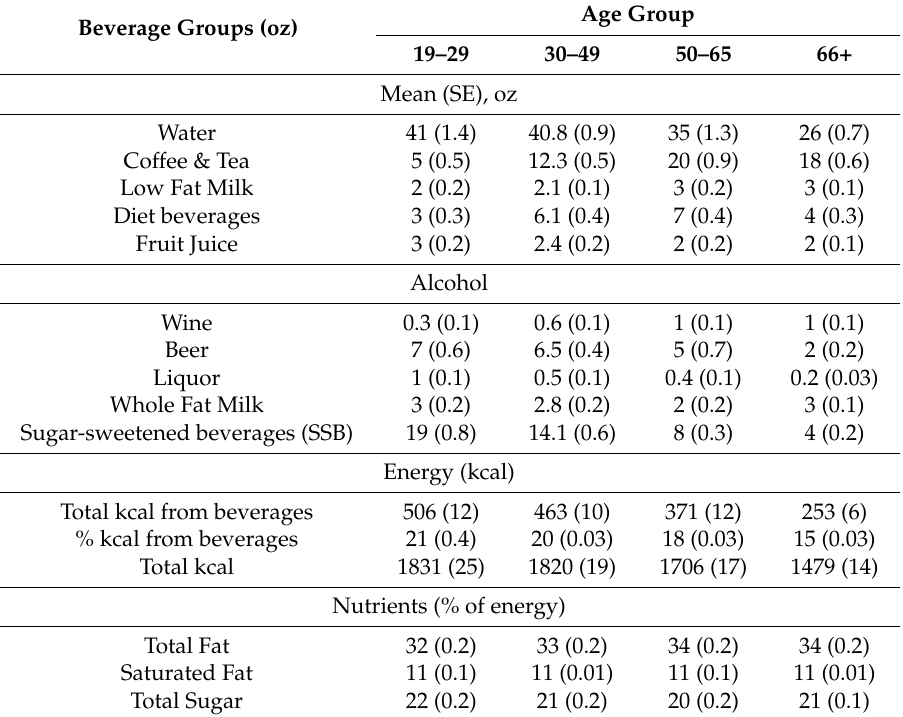
Table 1. Reported consumption of beverages, energy, and macronutrients among adults (19+), NHANES 2007–2012.